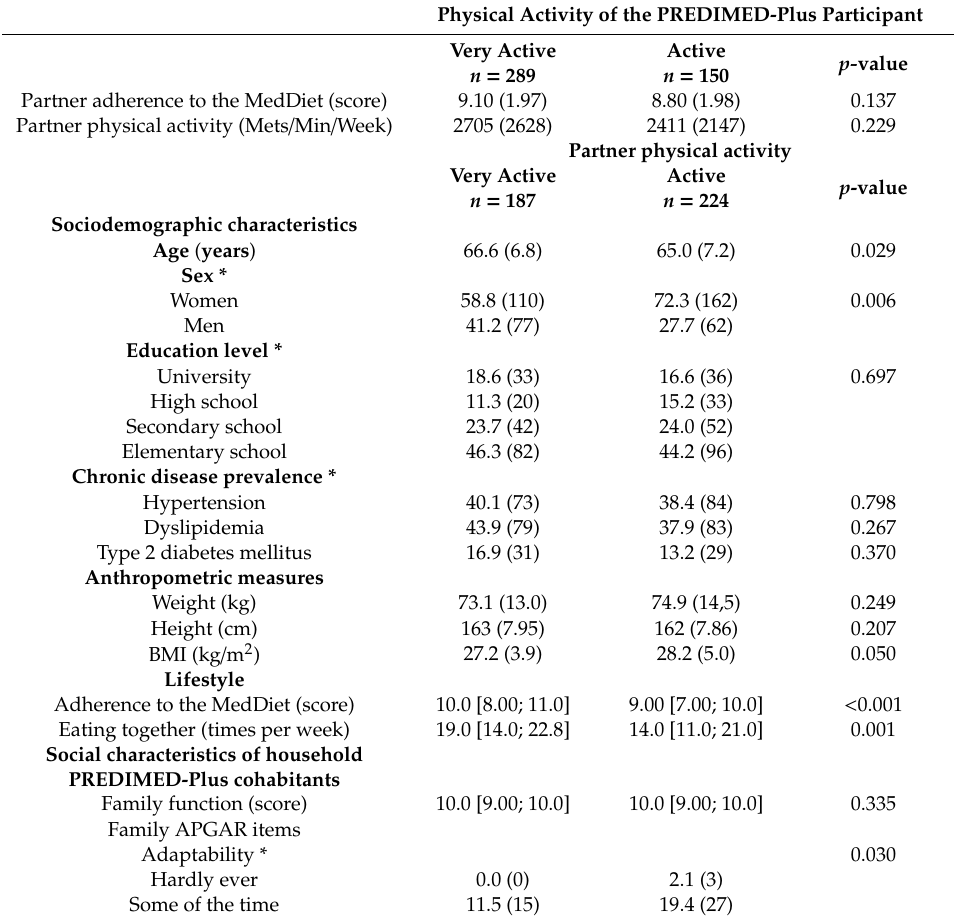
Table 3. General characteristics of the household PREDIMED-Plus cohabitants according to physical activity